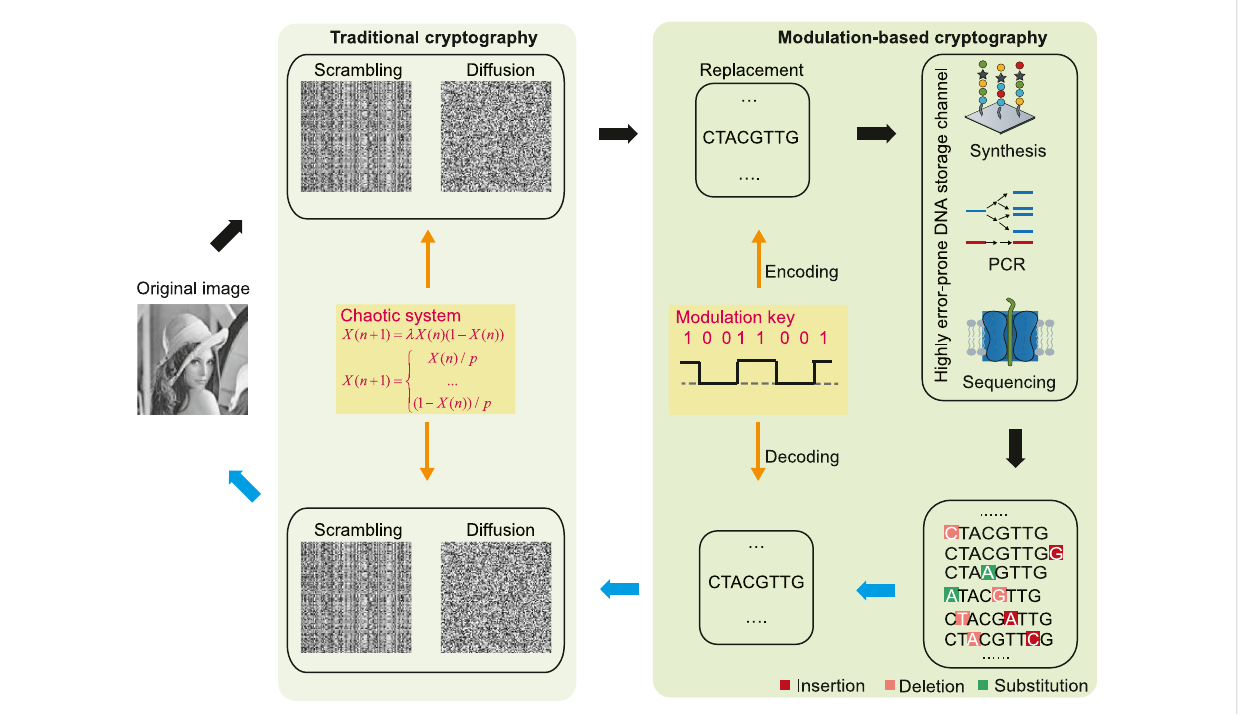
FIGURE 2 Schematic diagram of encryption and decryption processes. To the left is traditional cryptography which includes scrambling and diffusion at the binary level. To the right is modulation-based cryptography at the highly error-prone DNA storage channel. Black arrows represent the encryption process, while blue arrows indicate the decryption